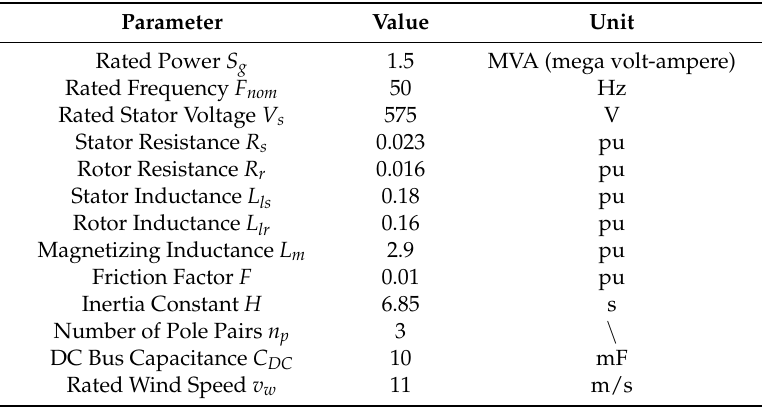
Table 5. Parameters of